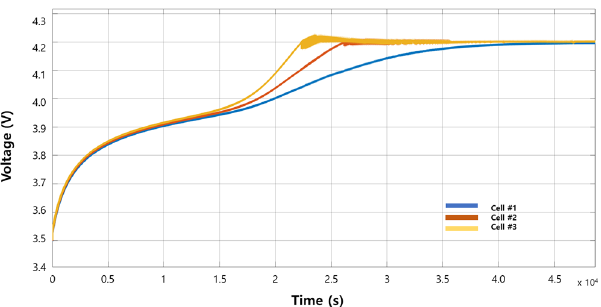
Figure 3. A representative result of cell voltages versus time from a